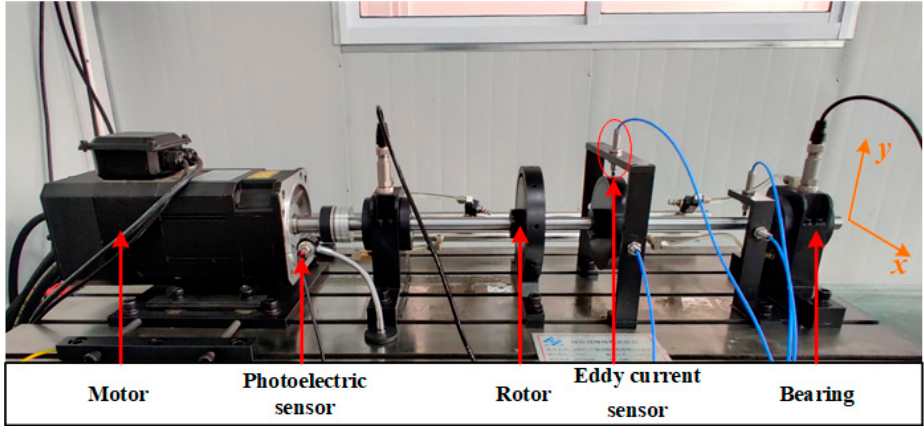
Figure 1. The dual-rotor sliding bearing system test rig.